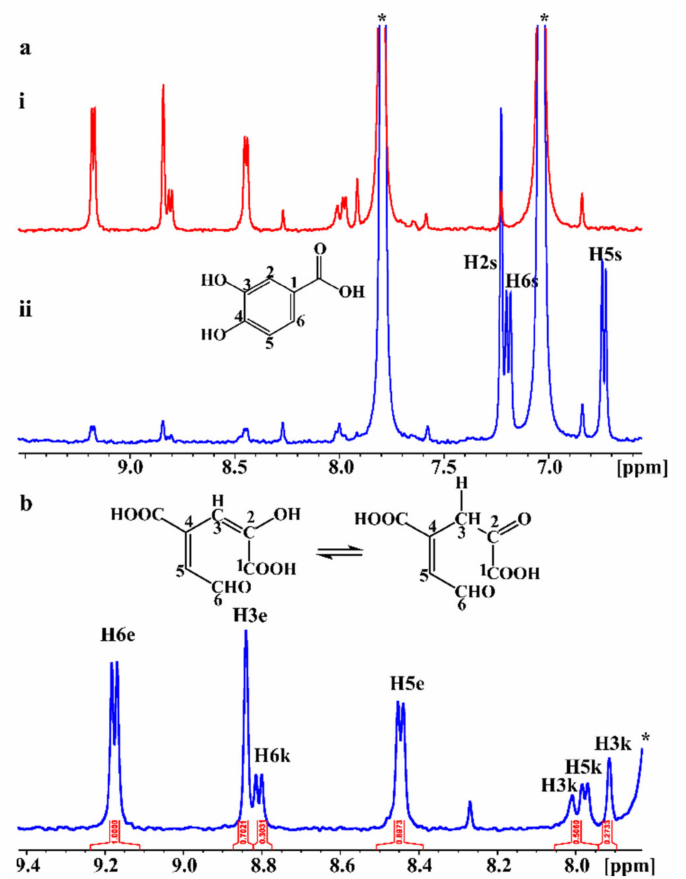
Figure 4. In situ monitoring of the biotransformation of PCA by PcaA, inside the NMR tube. ( a ) 1 H NMR spectra 2 h (blue spectrum, ( i )) and 24 h (red spectrum, ( ii )) after the addition of PCA to PCA 4,5 dioxygenase. 1 H NMR resonances of the substrate are shown in the blue spectrum. The asterisk (*) denotes protons of imidazole present in the buffer. ( b ) Expanded region (7.8–9.4 ppm) of the 1 H NMR spectrum of Figure 4aii and the chemical structures of the enol (left) and keto (right) forms (number of scans = 64, acquisition time = 4 s, relaxation delay = 1.5 s, total experimental time = 6 min 22